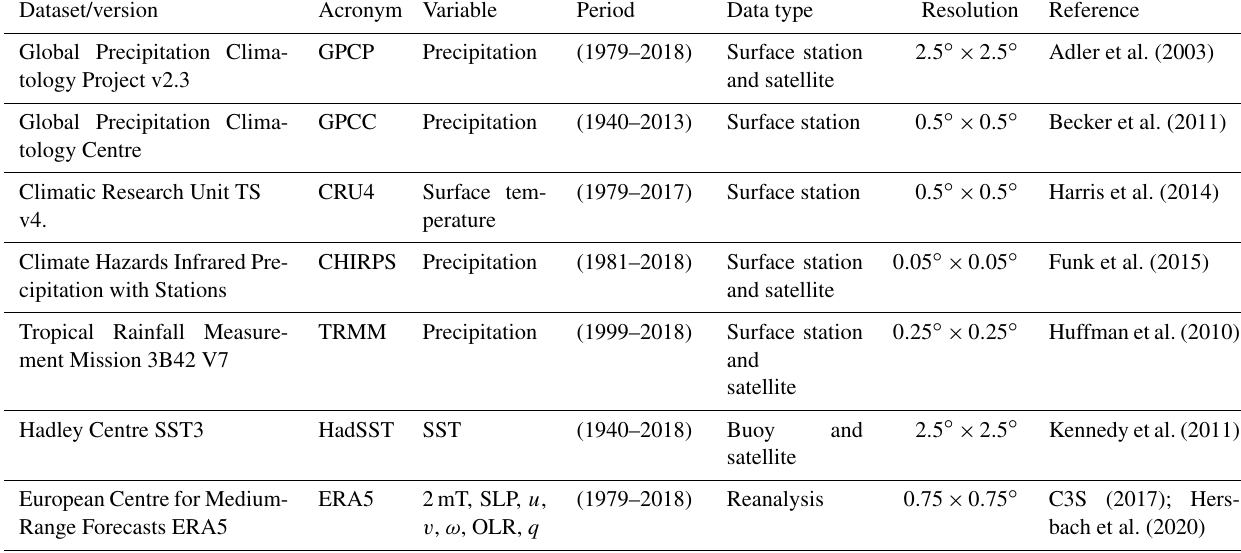
Table 1. Summary of the datasets used in this study. For each dataset, the acronym used hereafter, the period of coverage, the field used and the horizontal resolution are shown. Some datasets extend further back in time, but only the satellite-era period is used in most of the datasets. The variables used are precipitation, surface-air temperature (2mT), sea-level pressure (SLP), SSTs, the x and y components of the wind ( u , v ), the Lagrangian tendency of air pressure ( ω ), outgoing longwave radiation (OLR), and specific humidity ( q